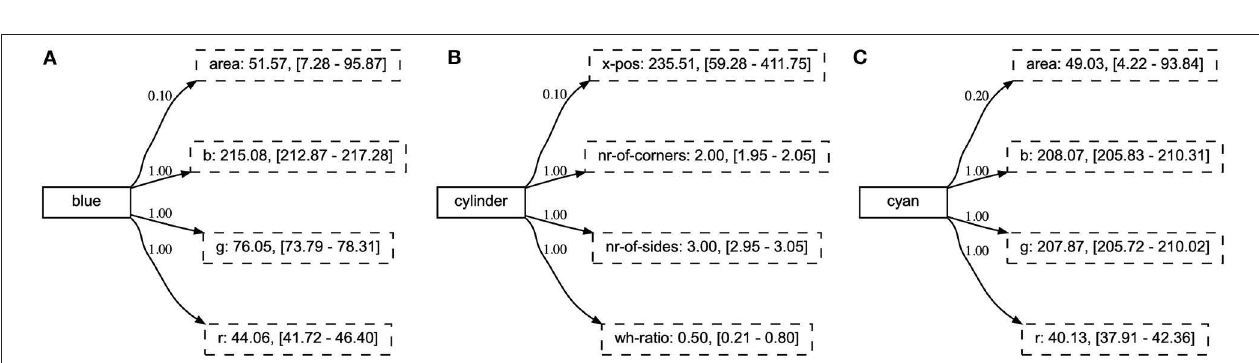
FIGURE 11 | The concept GRAY after each of the five phases: (A) phase 1, (B) phase 2, (C) phase 3, (D) phase 4, and (E) phase 5. The relevant attributes obtain a high certainty score after the first phase of the experiment.